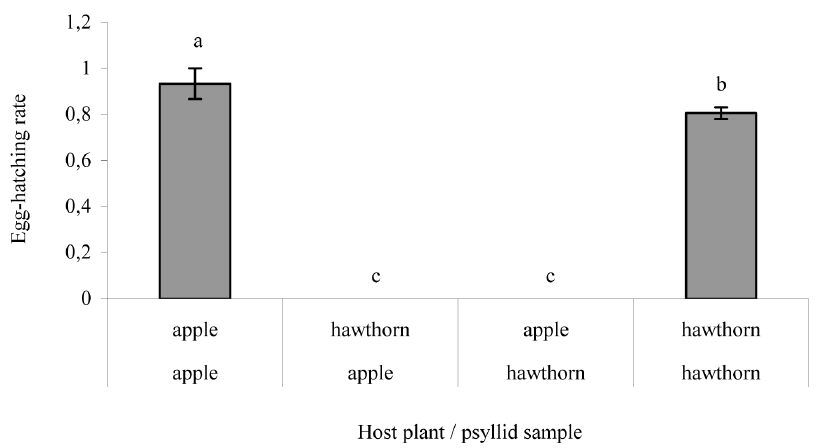
Figure 2. Egg hatching of Cacopsyllamelanoneura . Egg-hatching rates of the two samples of Cacopsylla melanoneura on the different host plants. Different letters indicate significant differences according to the Wald chi-square test ( a =0.05).